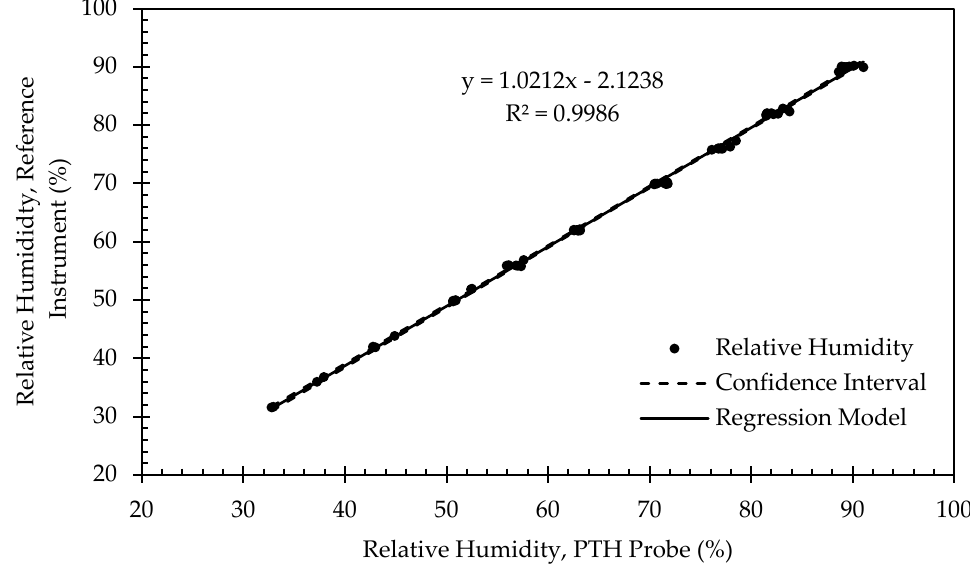
Figure 12. Regression model and corresponding confidence interval for relative humidity calibration data from representative PTH probe (SN: 0x0005).